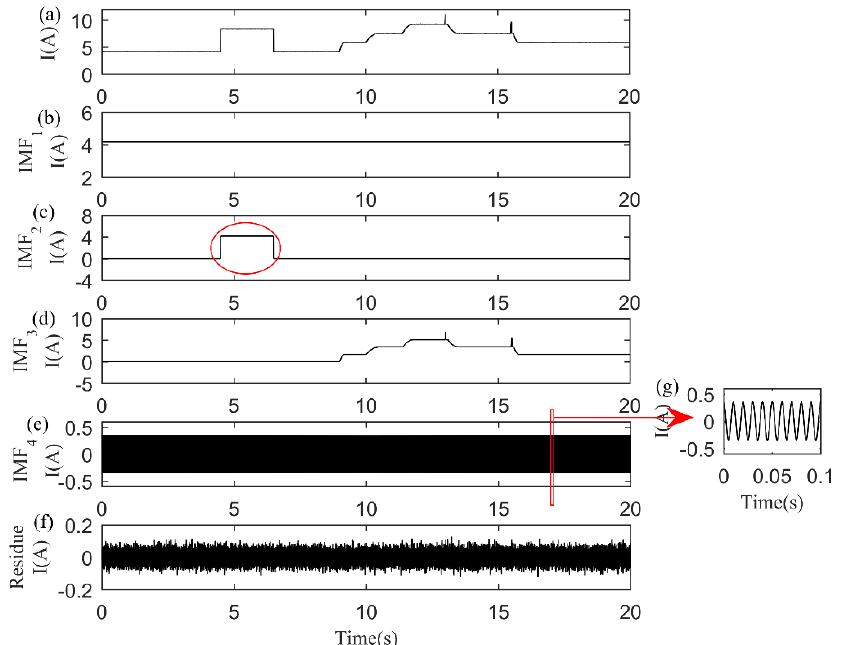
Figure 23. MBMD decomposition diagram of the experimental signal. ( a ) Experimental current signal; ( b ) DC signal; ( c ) Broadband signal; ( d ) Narrowband signal; ( e ) Harmonic signal; ( f ) Noise signal; ( g ) A 0.1 s signal extract from ( d ).